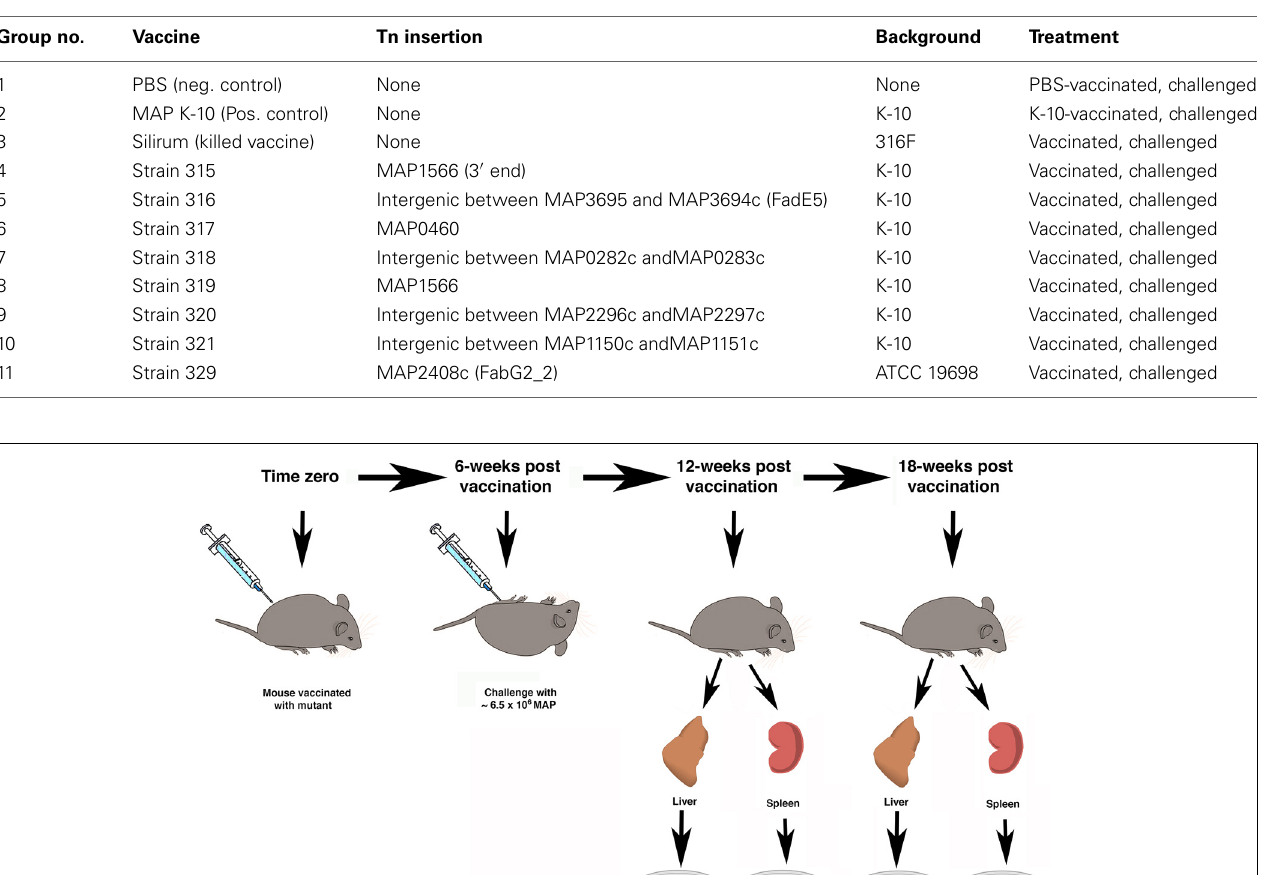
intraperitoneal injection with live MAP 6 weeks after vaccination. Five mice in each of 11 groups were sacrificed at the 12- and 18-week time points. Organs were collected for mycobacterial culture on Middlebrook media (green